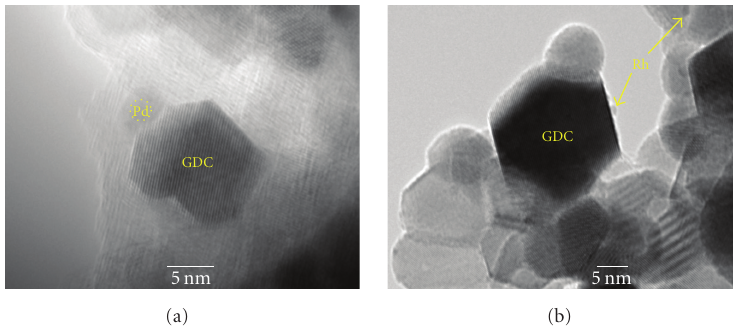
Figure 11: TEM images of the postreformed Pd-based (a) and Rh-based (b) catalyst.